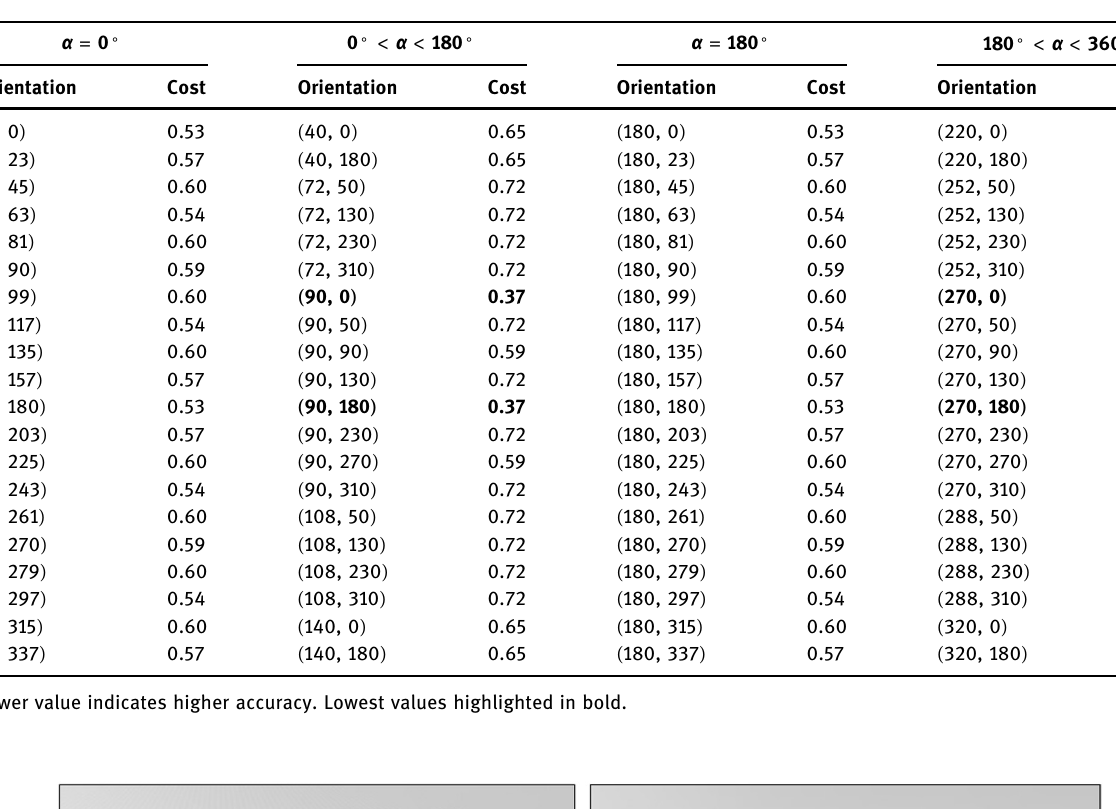
Table 6: Evaluation of critical points for case 2